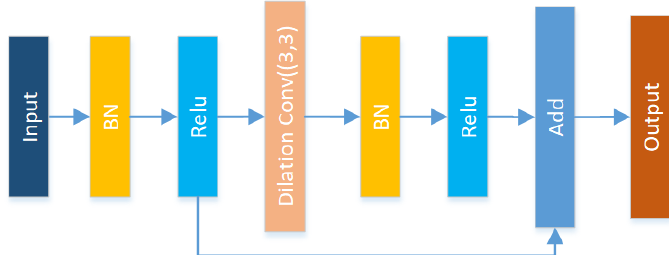
Figure 9. Res-Dilated block: adding an dilated convolution structure to